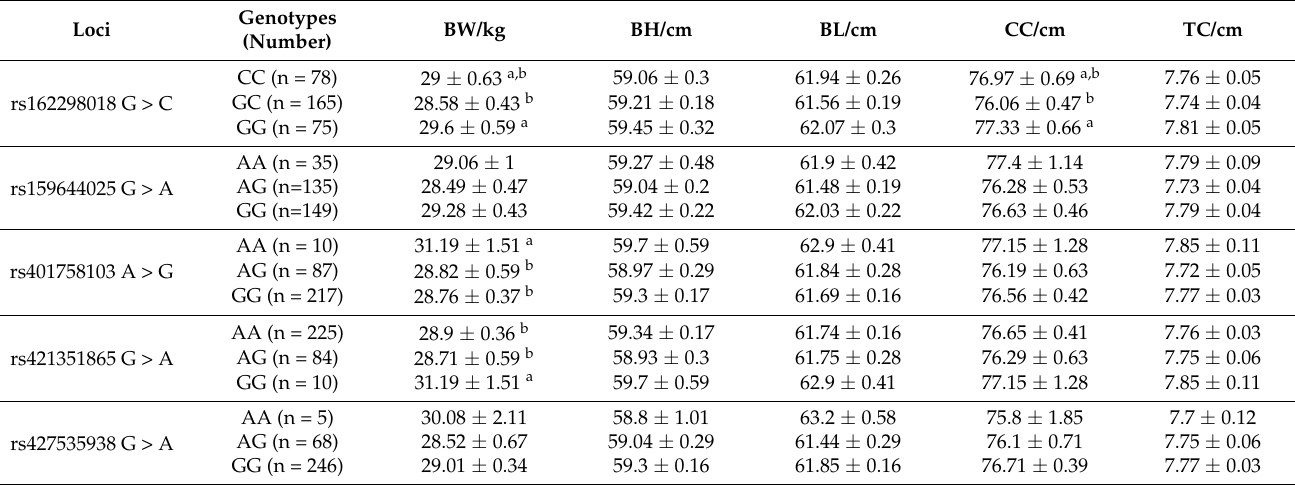
Table 6. Association analysis between the ARNT gene polymorphisms and growth traits of 4-month- old Ujimiqin sheep.